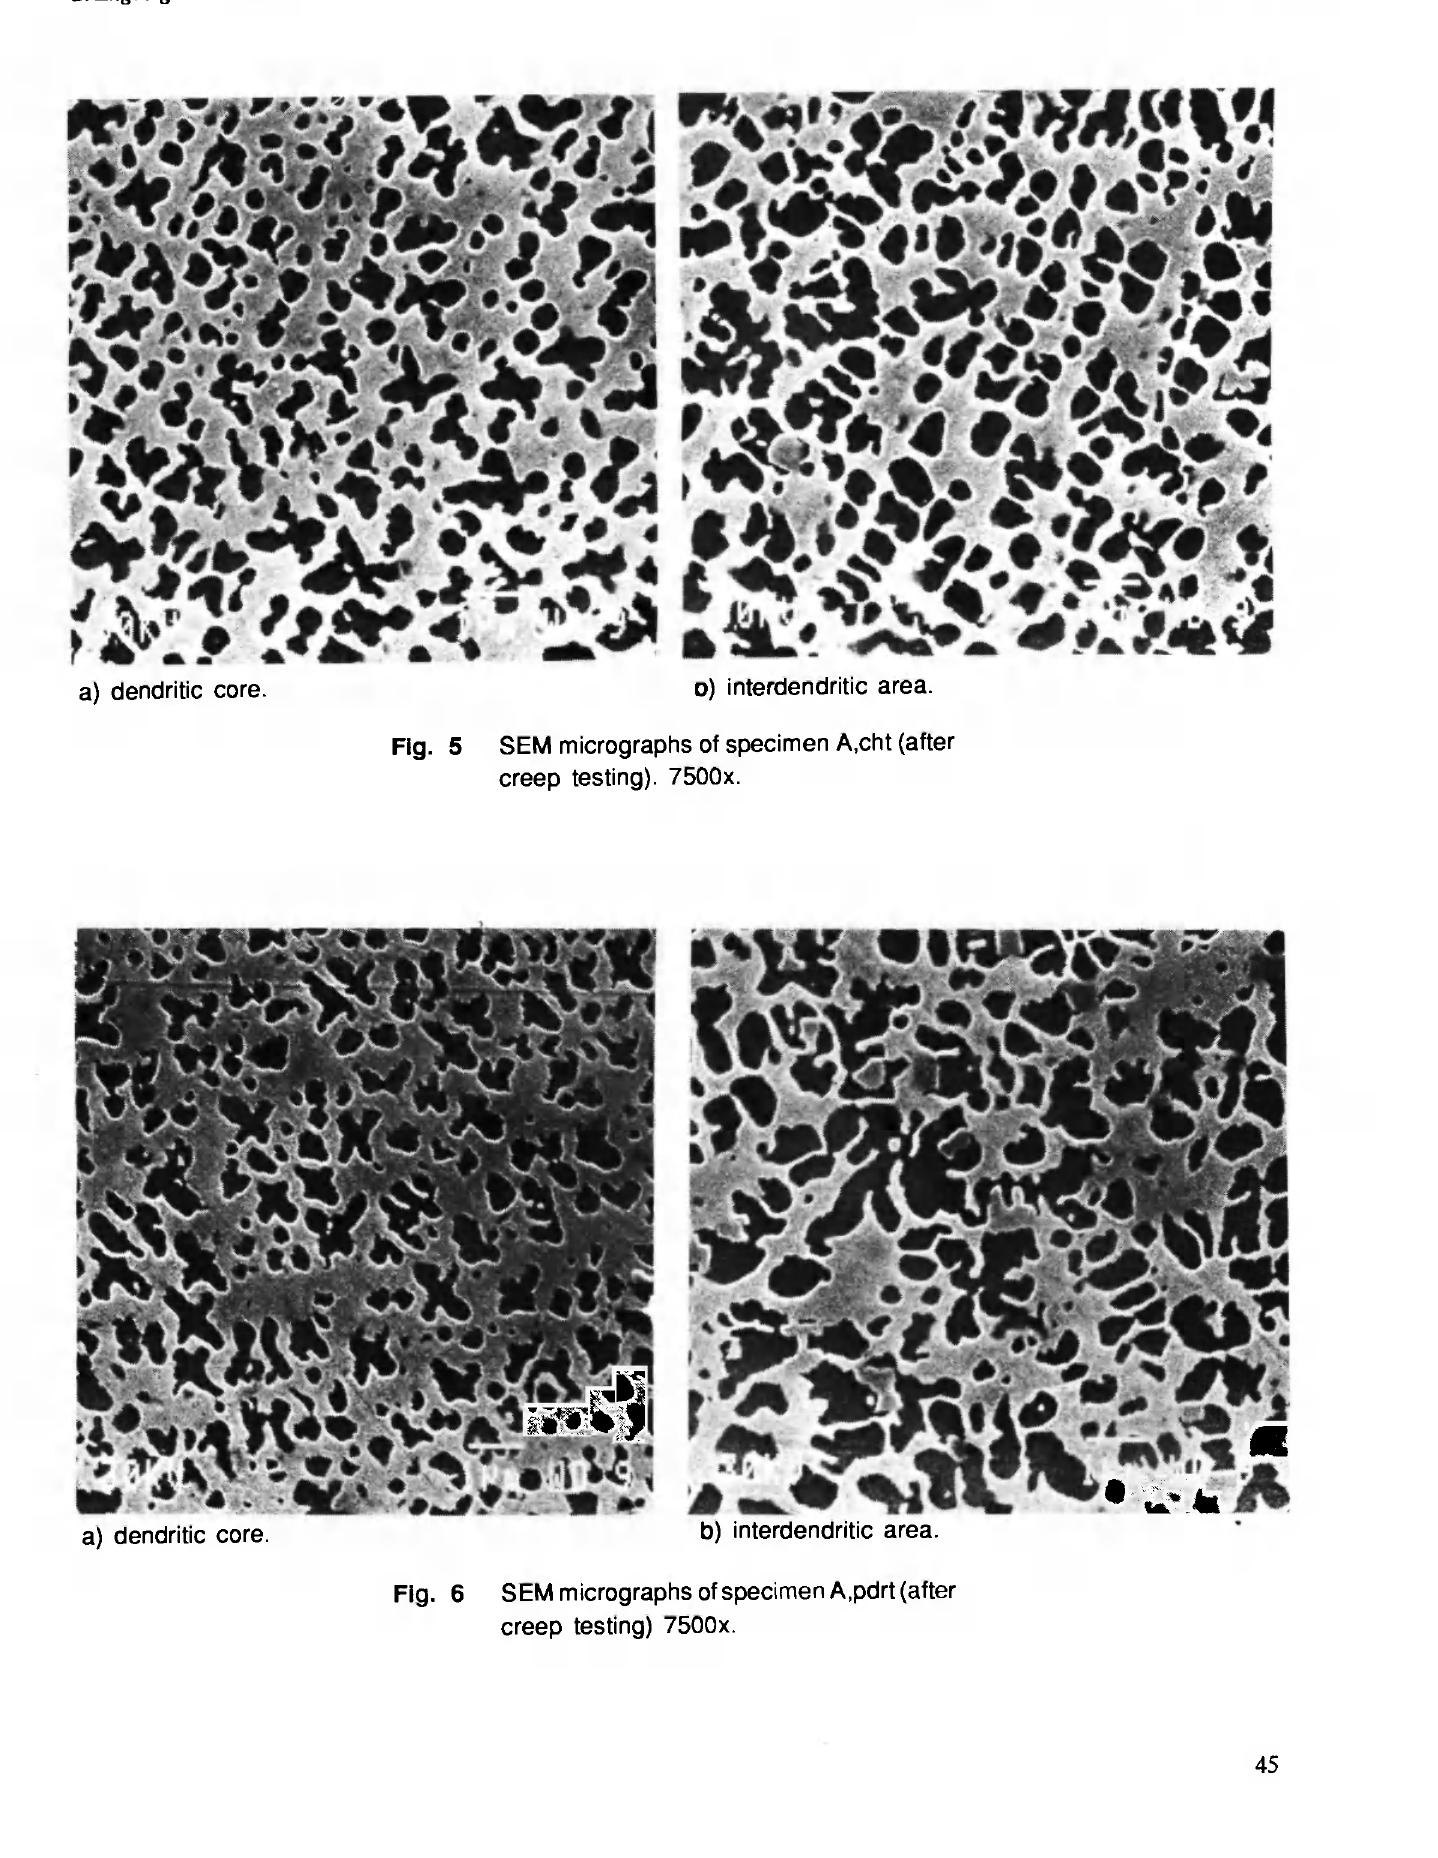
S EM micrographs of specimen A,pdrt (after creep testing)